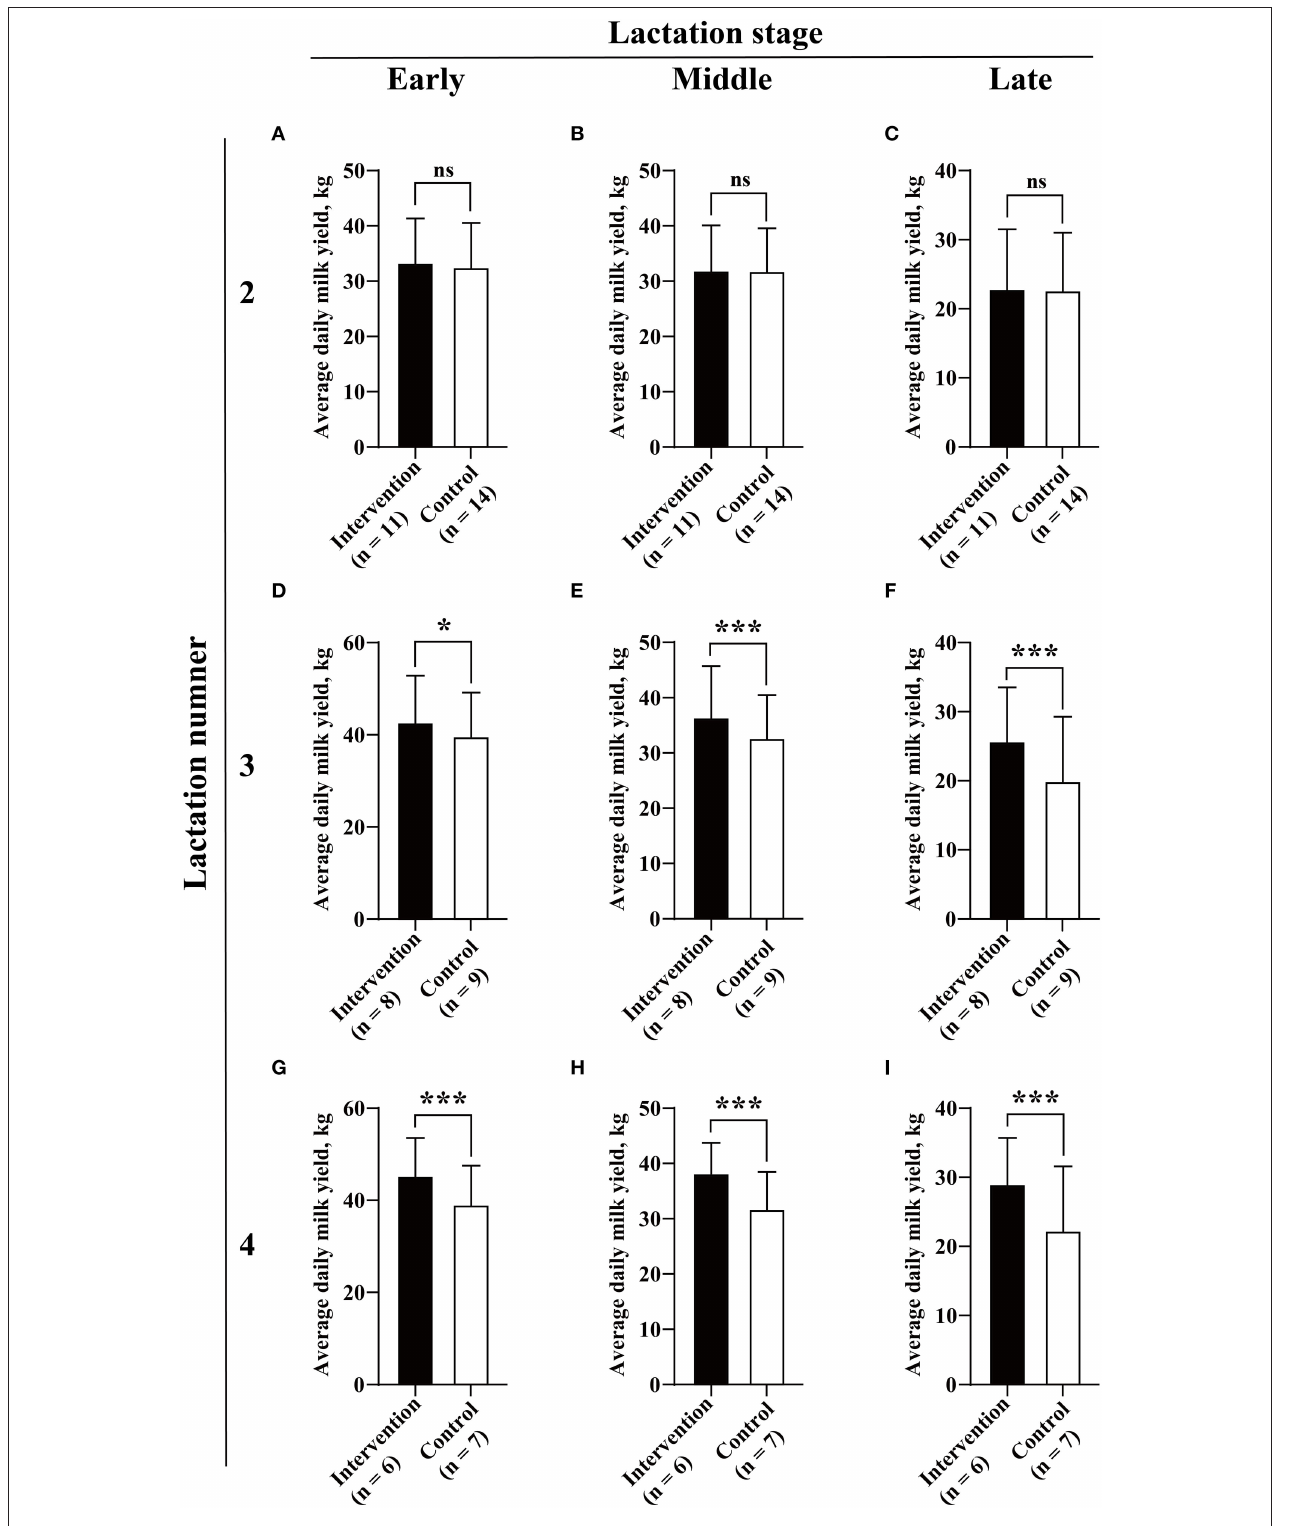
FIGURE 4 | Association between BLV infection and milk yield. Average daily milk yield (A–I) for each of three lactation numbers (2, 3, and 4) and stages (early, middle, and late) were compared between the intervention (in black) and control (in white) groups by Student’s t -test. Data are shown as mean ± SD, and the symbols indicate P ≤ 0.001 (***), P ≤ 0.050 (*), and P > 0.050 (ns), respectively.